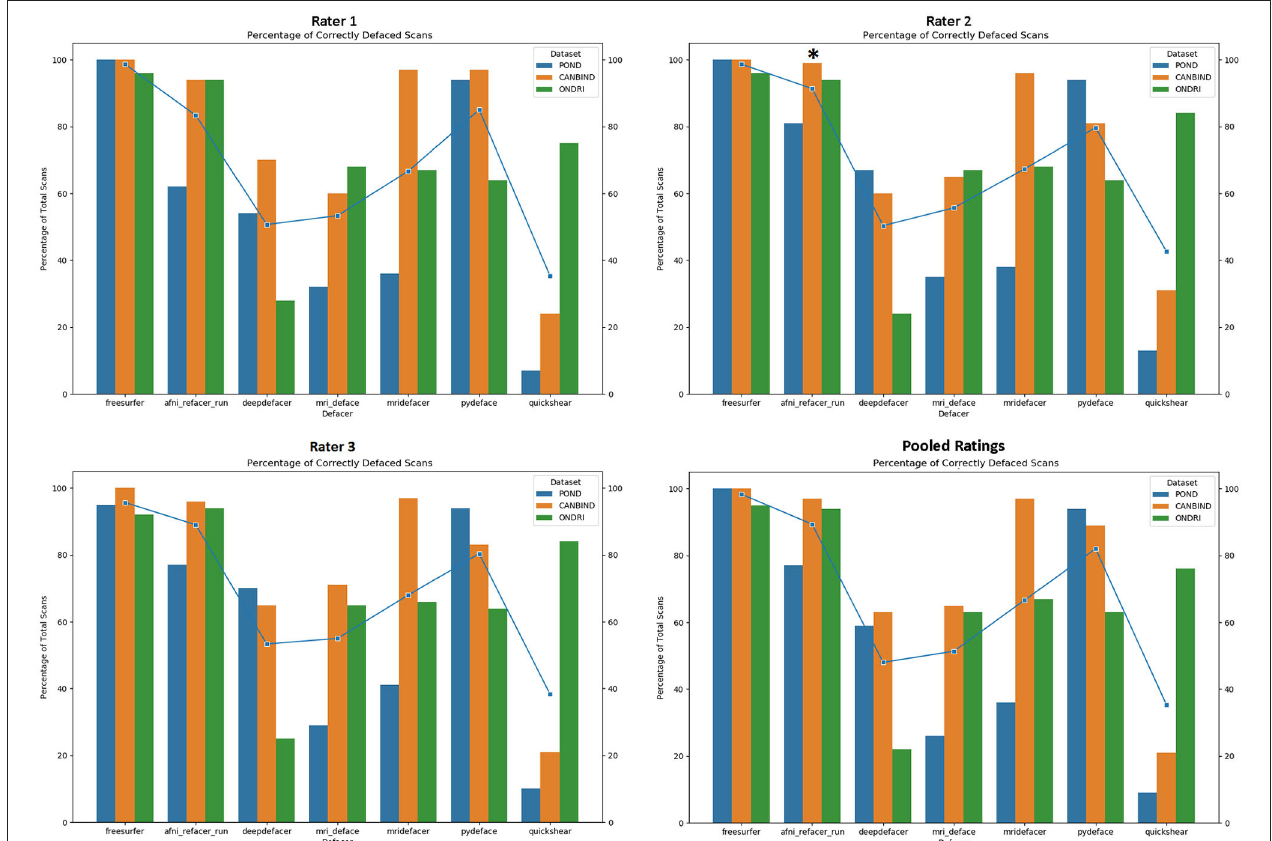
FIGURE 2 | Percentage of scans passed by each rater, split by dataset and defacing algorithm. Markers indicate the average percentage for each algorithm. Pooled ratings indicate the percentage of scans that passed based on rater consensus for each scan. *Disclaimer: afni_refacer_run ratings had to be redone due to a major software update after initial data collection. Due to the unavailability of the original Rater 2, these ratings were completed by a different person.